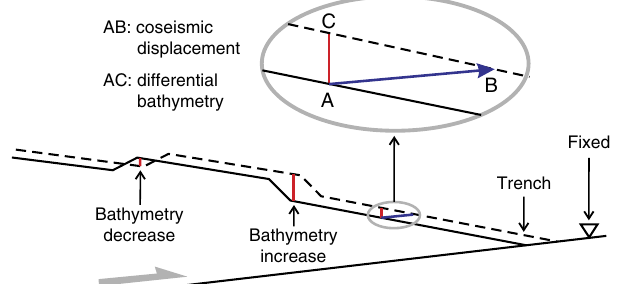
Figure 2 | Cartoon illustration of the generation of differential bathymetry by a trench-breaching subduction earthquake. Solid and dashed lines show the bathymetry before and after the earthquake, respectively. While coseismic deformation is of long wavelength, local seafloor slope variations can lead to coherent short-wavelength features of bathymetry decrease or